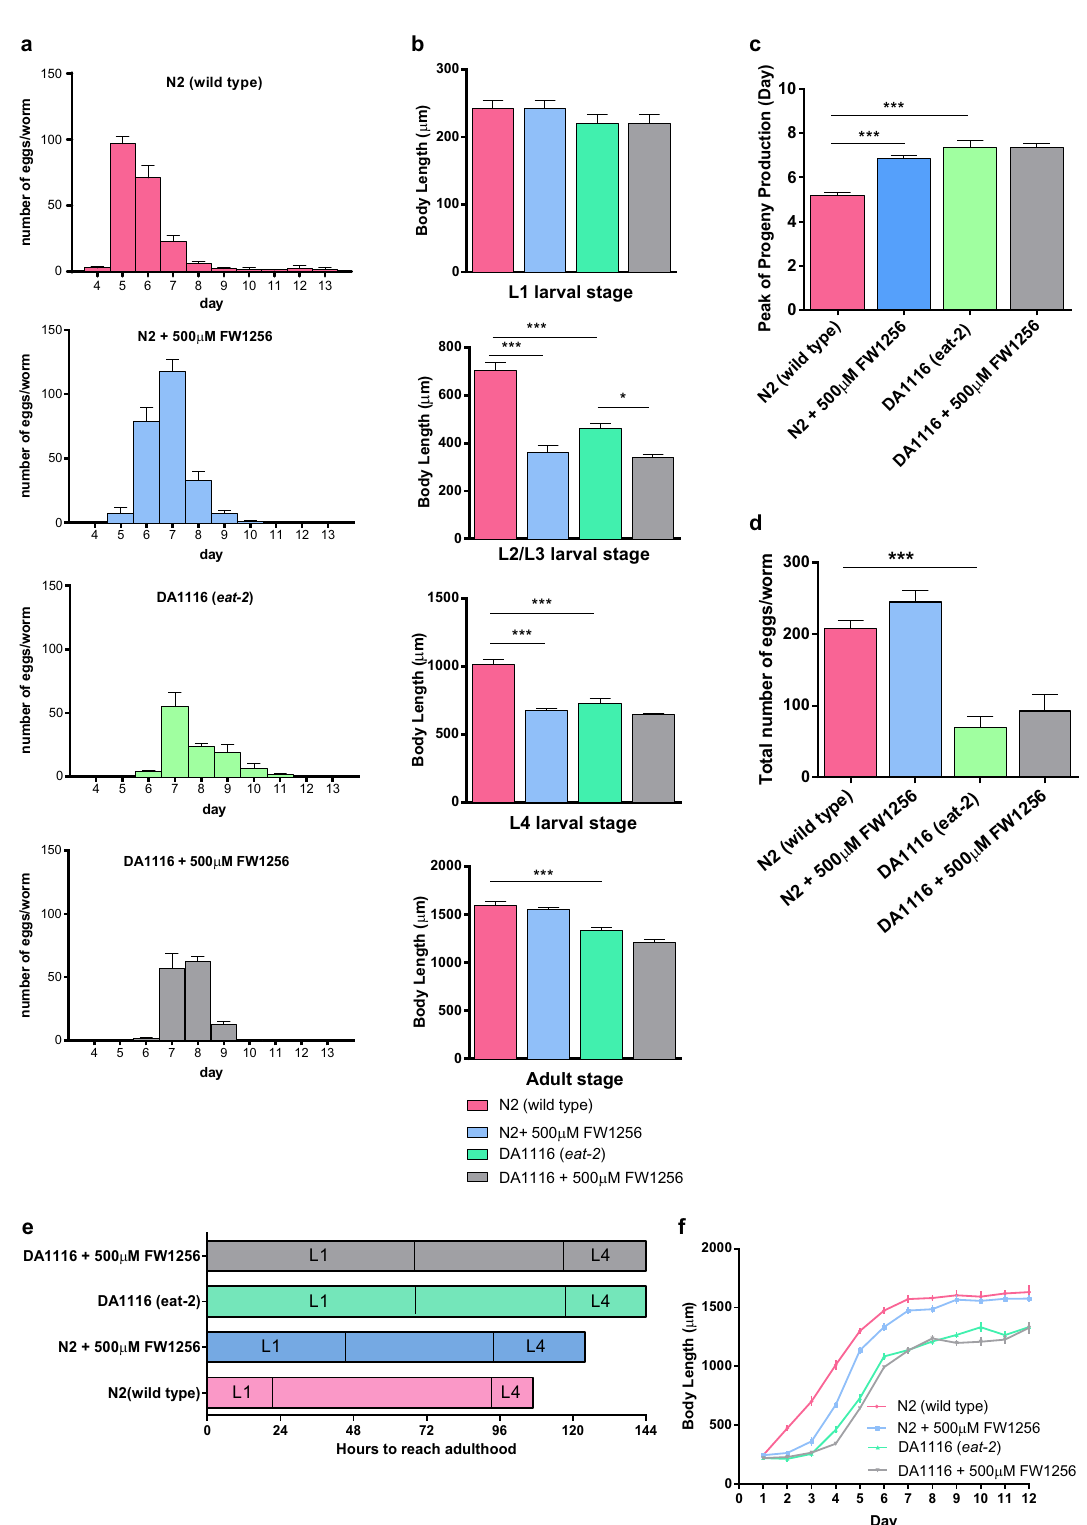
Fig. 4 Comparing to CR, FW1256 elicits fewer fi tness costs in C. elegans . a Egg laying study reveals reproduction pro fi les of each group of C. elegans . b Comparison of body length at L1 larval stage, L2/L3 larval stage, L4 larval stage and adult stage. c Day of peak progeny production. d Total number of eggs laid by a nematode. e Developmental timing and schedules from eggs into adults of WT and eat-2 mutants (with or without exposure to 500 µM of FW1256). f Measurement of body length of nematodes from age day 1 (L1 larval stage) to age day 12 (adult stage). ( n = 10 animals each, one-way ANOVA with Bonferroni ’ s post-test, * p < 0.05, *** p <